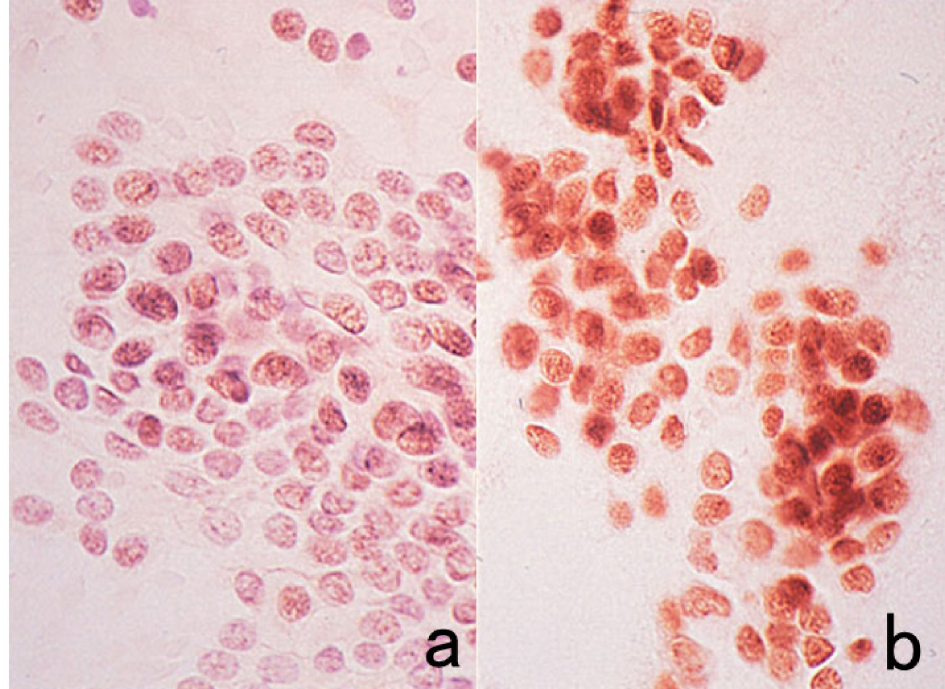
Figure 37. ER immunostaining for an aspiration cytology preparation after ethanol fixation. ( a ): Without pretreatment and ( b ): HIER with pressure pan heating at 121 ◦ C for 10 min in 10 mM citrate buffer, pH 7.0. HIER is effective for ER immunolocalization even in cytology